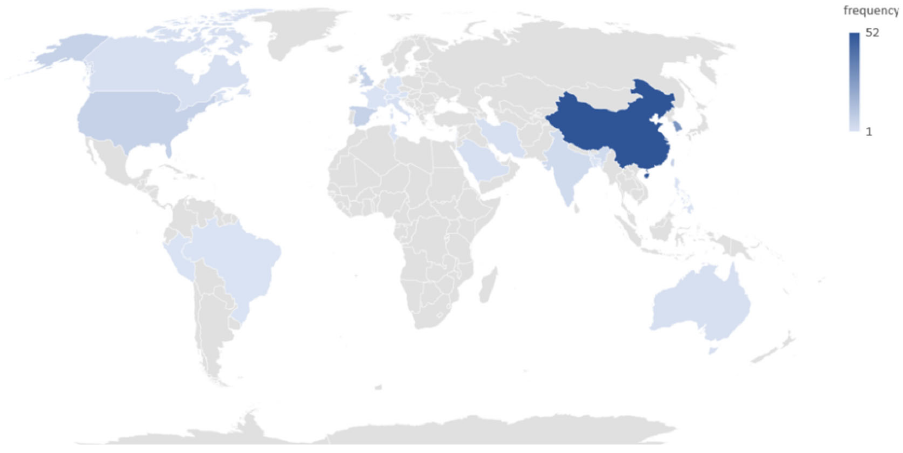
Figure 4. Countries/regions engaged in academic research.